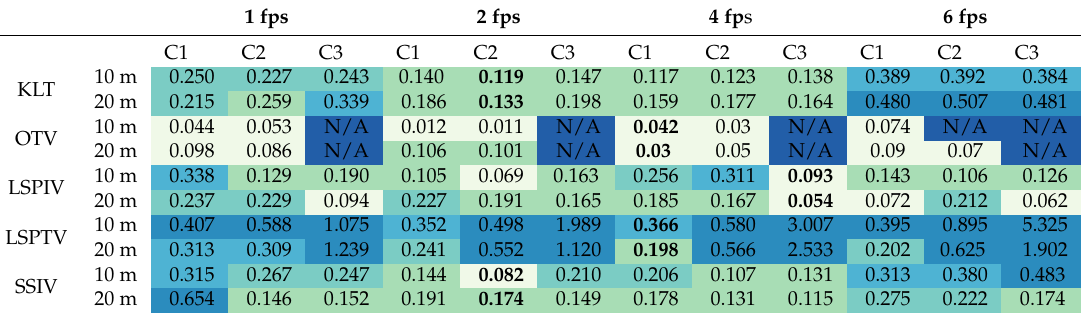
Table 3. Sensitivity scores for all algorithms at cross-sections 10 m and 20 m. (C1 = Configuration 1, C2 = Configuration 2, and C3 = Configuration 3—See Table 1). Light colors represent lowest sensitivity scores, increasing as the colors darken. Darkest values are those which have been excluded from the sensitivity analysis. The configurations which have the lowest sensitivity scores are reported in bold text for each algorithm. 1